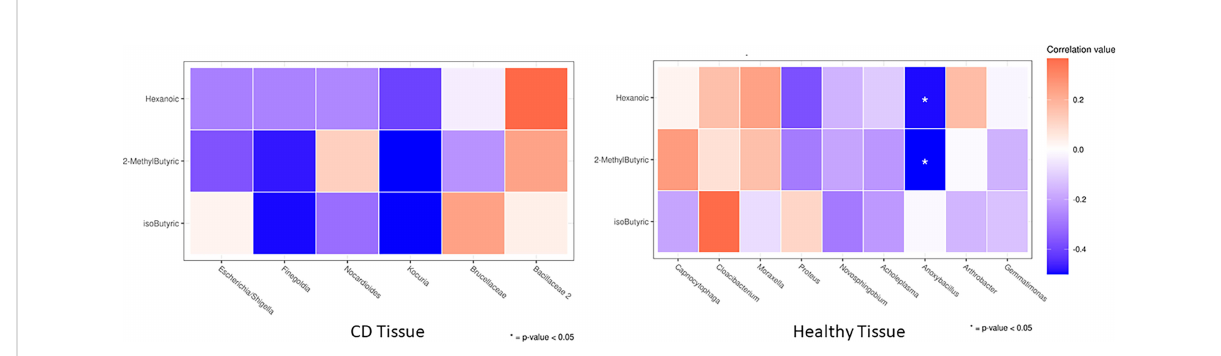
FIGURE 9 Heatmap of the Spearman correlation values between signi fi cantly changed FFAs (rows) and taxa that were differently abundant in DESeq2 analyses (columns) between the fi rst surgery and relapse patients. As it is an explorative analysis, non – adjusted p – values lower than 0.05 are marked with an